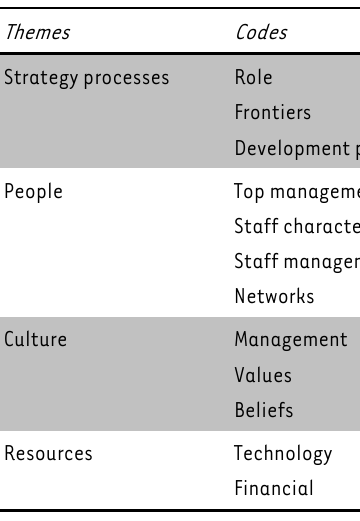
Qualitative data analysis